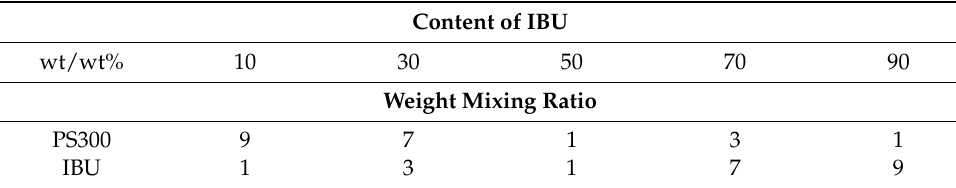
Table 1. Composition of various